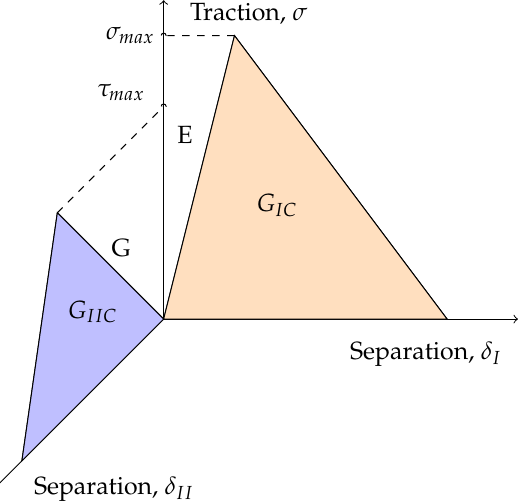
Figure 6. Three-dimensional representation of the fracture envelope of an adhesive, using triangular traction–separation laws. Pure mode I (orange) and pure mode II